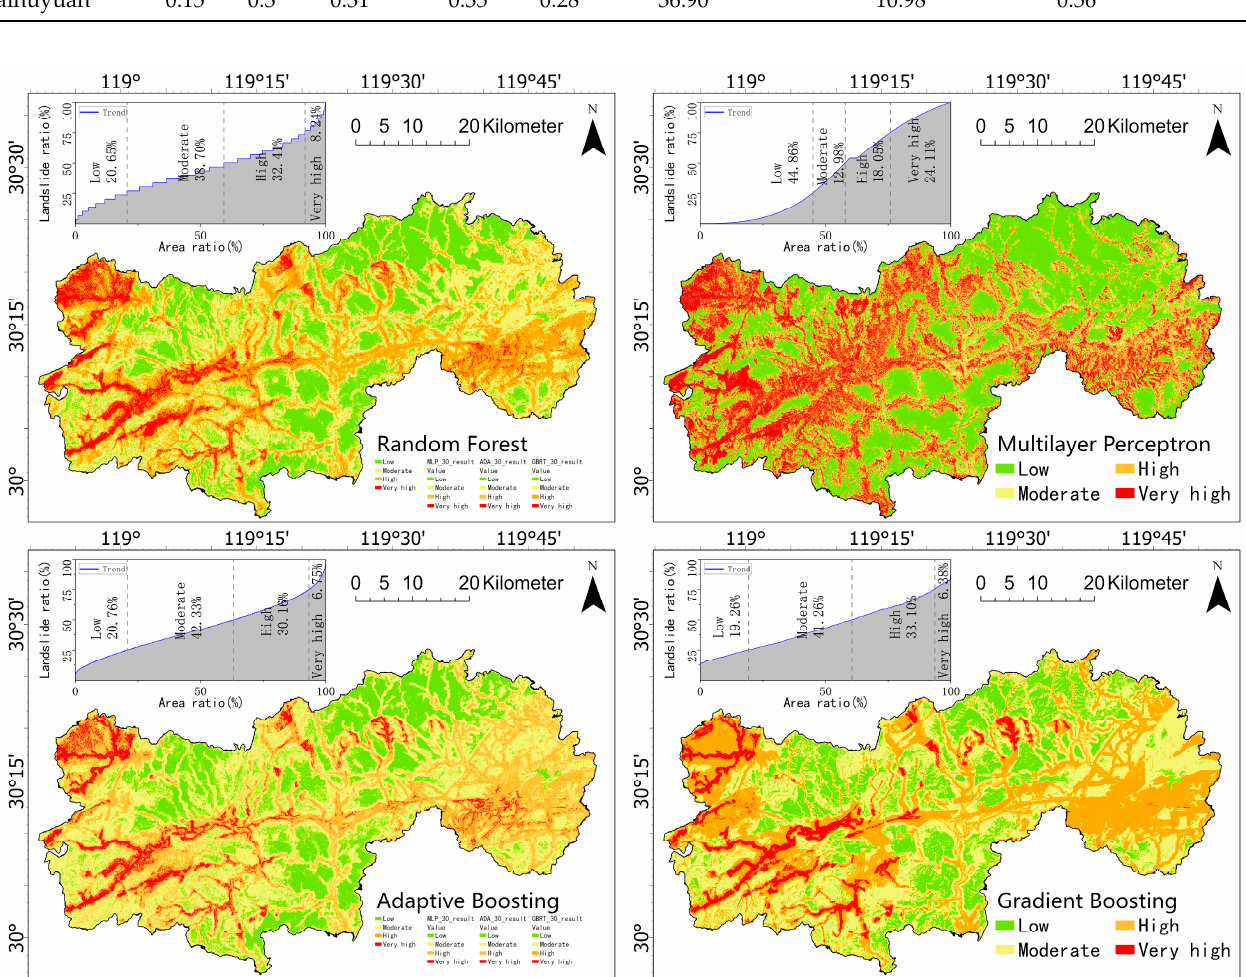
Figure 5. Landslide susceptibility maps predicted by the RF, MLP, AdaBoost, and GBDT machine learning methods.